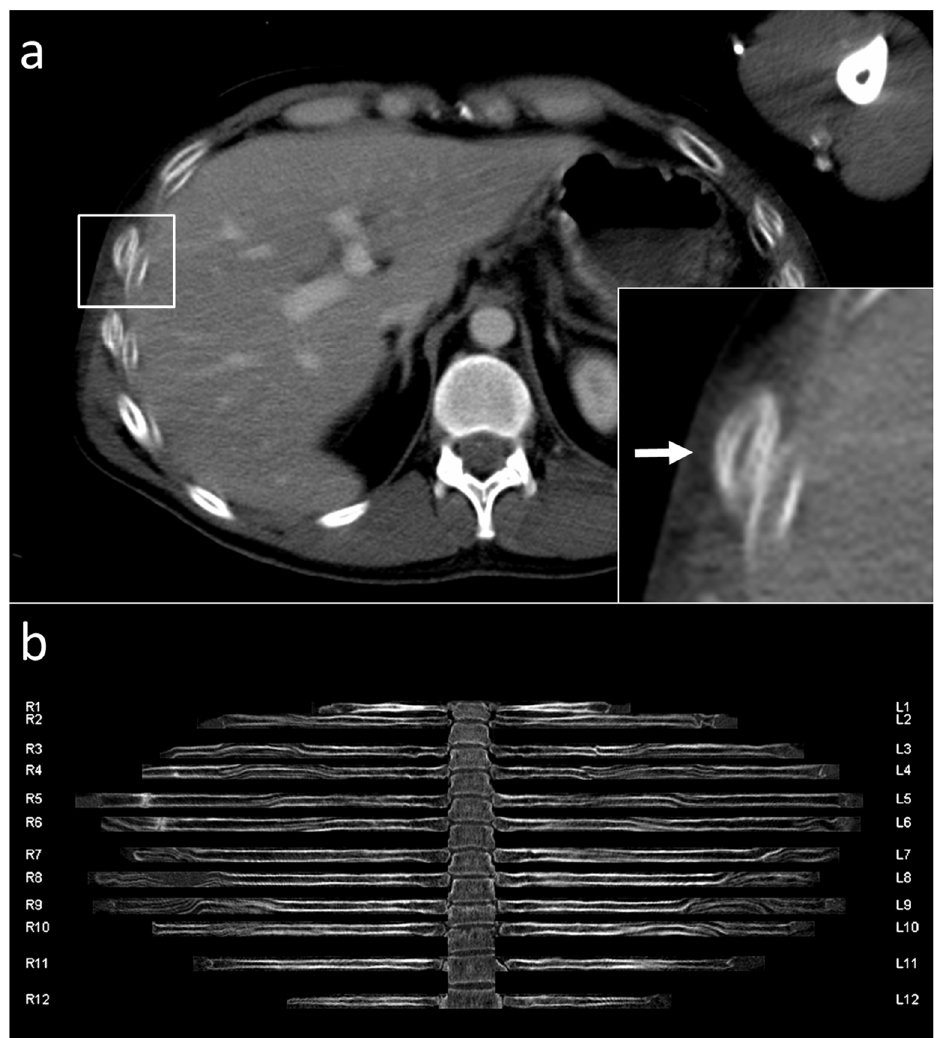
Figure 3. Unfolded rib view of a 33-year-old male patient with breathing artifacts. Typical double- contours (white arrow) in the axial view ( a ) appear like wave shape artifacts in the unfolded view ( b ). R1-12 refers to the 1st to 12th rib of the right hemithorax. L1-12 refers to the 1st to 12th rib of the left hemithorax.